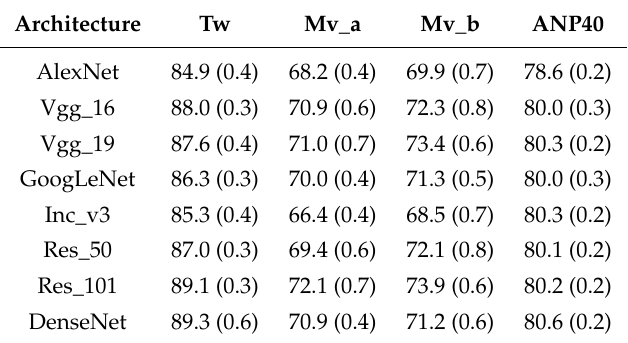
Figure 6. Consistency evaluation of the eight architectures under the layer replacement configuration; the plot gives the architectures on the x -axis and the corresponding total amount of collected points on the y -axis. Table 6. Experimental results: Session #1, layer